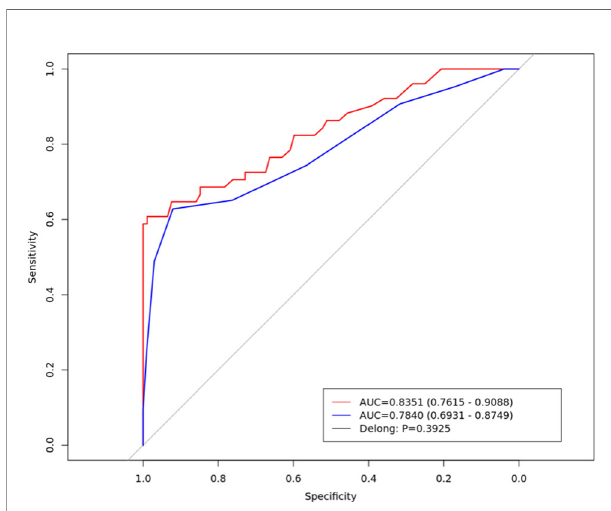
FIGURE 3 | The Receiver operating characteristic curve of the radiomics prediction model in the training set (red line) and external validation set (blue